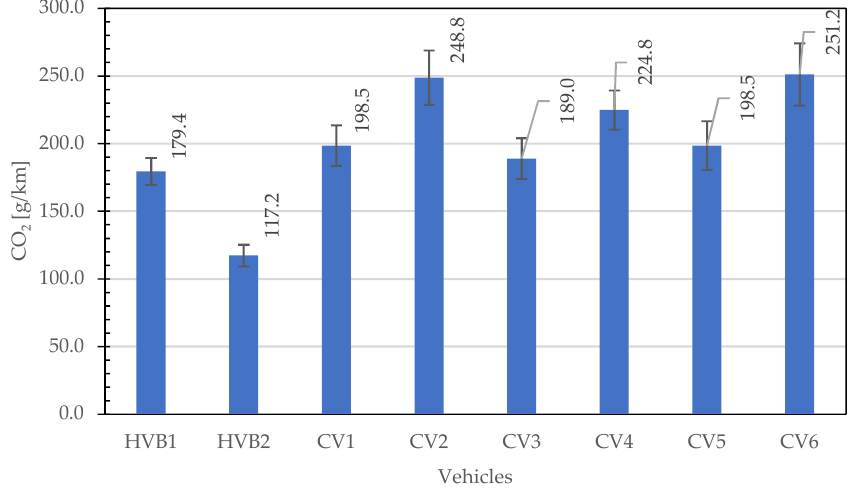
Figure 8. CO 2 emission factor for the examined vehicles.